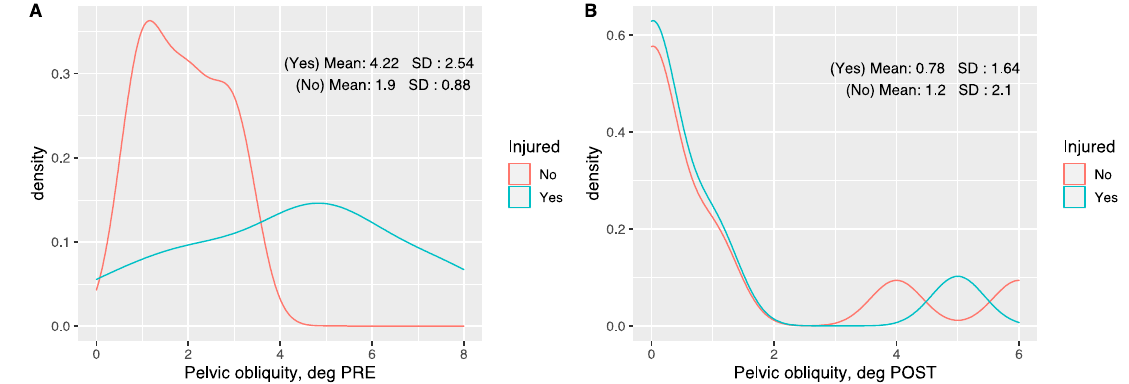
Figure 4. Density plots comparing the differences between injured and non-injured triathletes in terms of the degree of pelvic obliquity between the ( A ) pre-retraining; ( B ) and post-retraining phase values. Higher density values on the ordinate axis point out which are the most probable values on the abscissa axis.